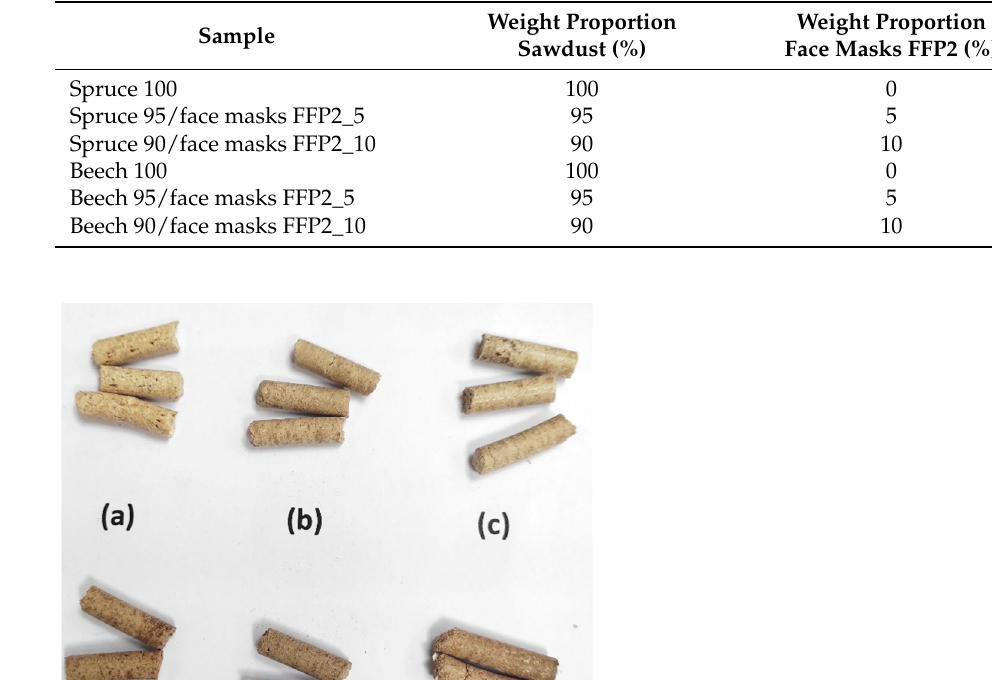
Table 1. Weight proportion of produced pellets.